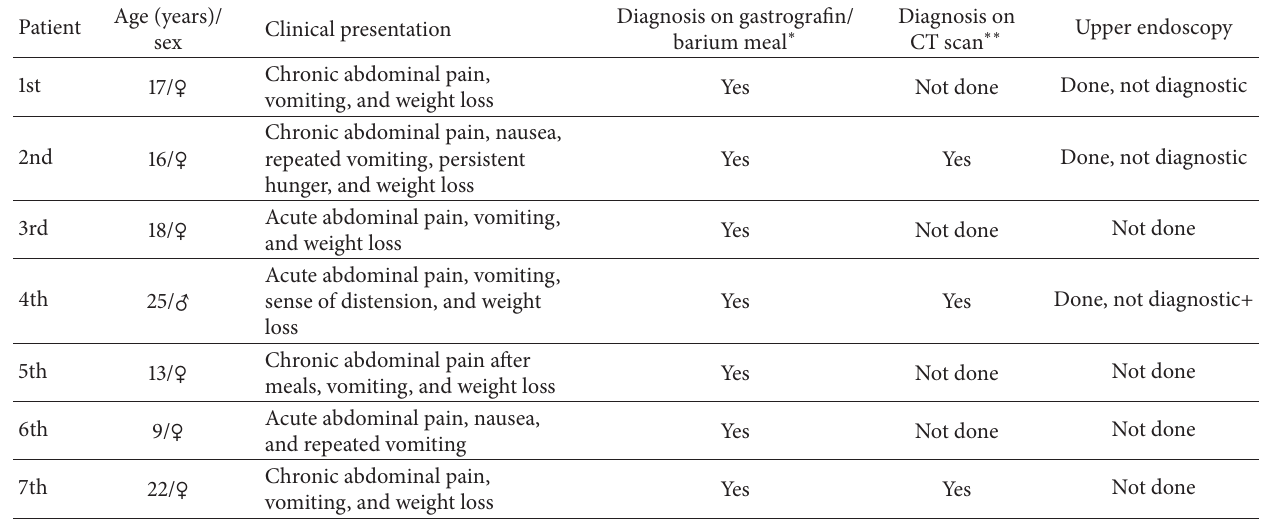
Table 1: Clinical, radiological, and endoscopic features of individual patients in the series.